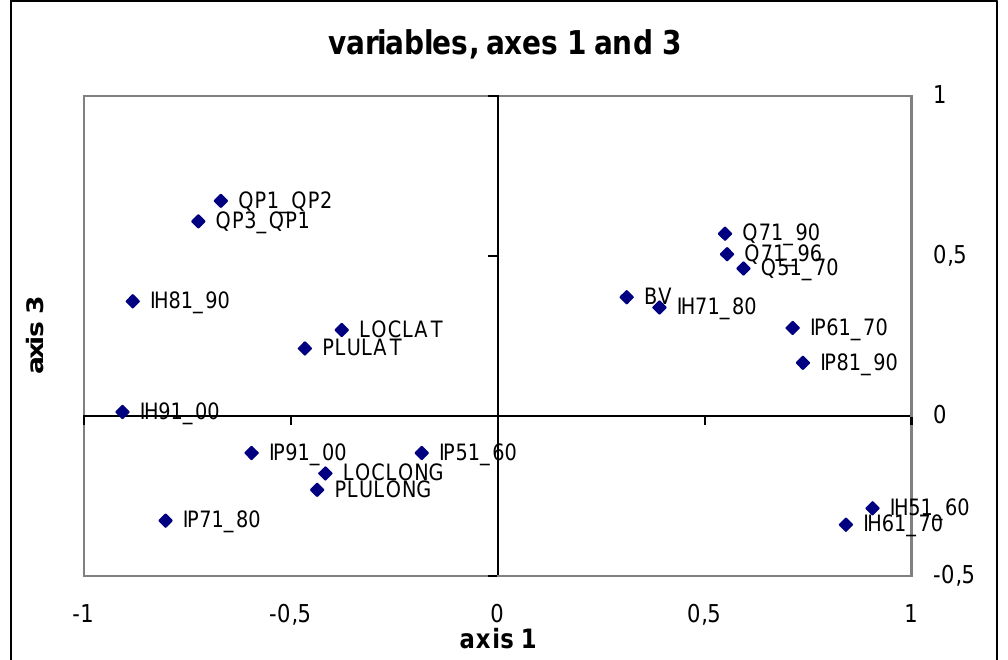
Figure 15. Variables space of the PCA, axes 1 and 3. variables, axes 1 and